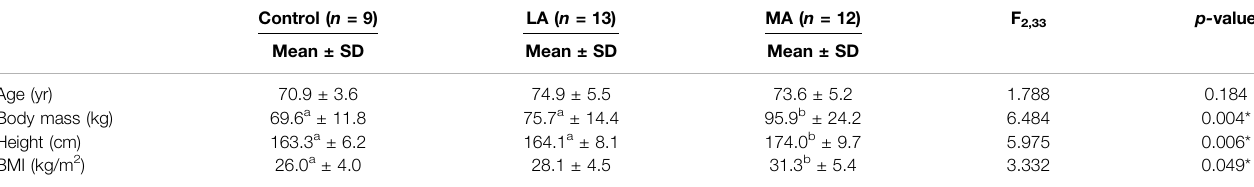
TABLE 1 | Demographics and functional mobility variables for three groups.